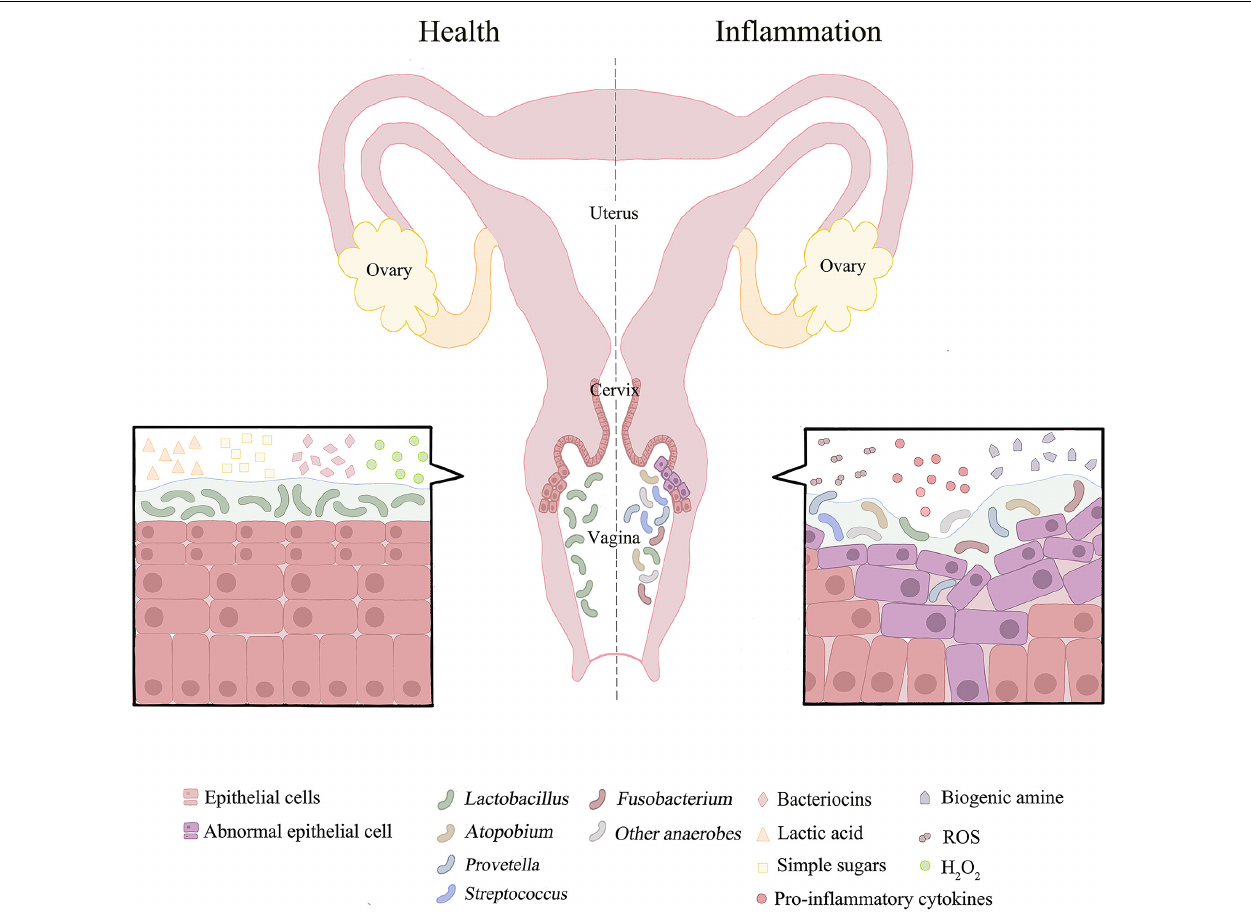
FIGURE 1 | The distribution of vaginal microorganisms in a healthy or inflammatory state. The vaginal microbial environment of healthy people is usually dominated by lactobacillus with high abundance. Lactobacillus depends on glycogen products for growth. Lactic acid, bacteriocins and H 2 O 2 produced by Lactobacillus may inhibit the growth and development of pathogenic bacteria. When female reproductive tract is in disorder or inflammation, the microbial community is dominated by anaerobic bacteria and has the characteristics of high diversity. This could results in pH > 4.5. Simultaneously promote oxidation and nitrification reactions. The associated pro-inflammatory cytokines and ROS are increased, and metabolites in female reproductive tract are converted from lactic acid to biogenic amines. In addition, microbial co-infection can damage epithelial cells and disrupt the mucosal